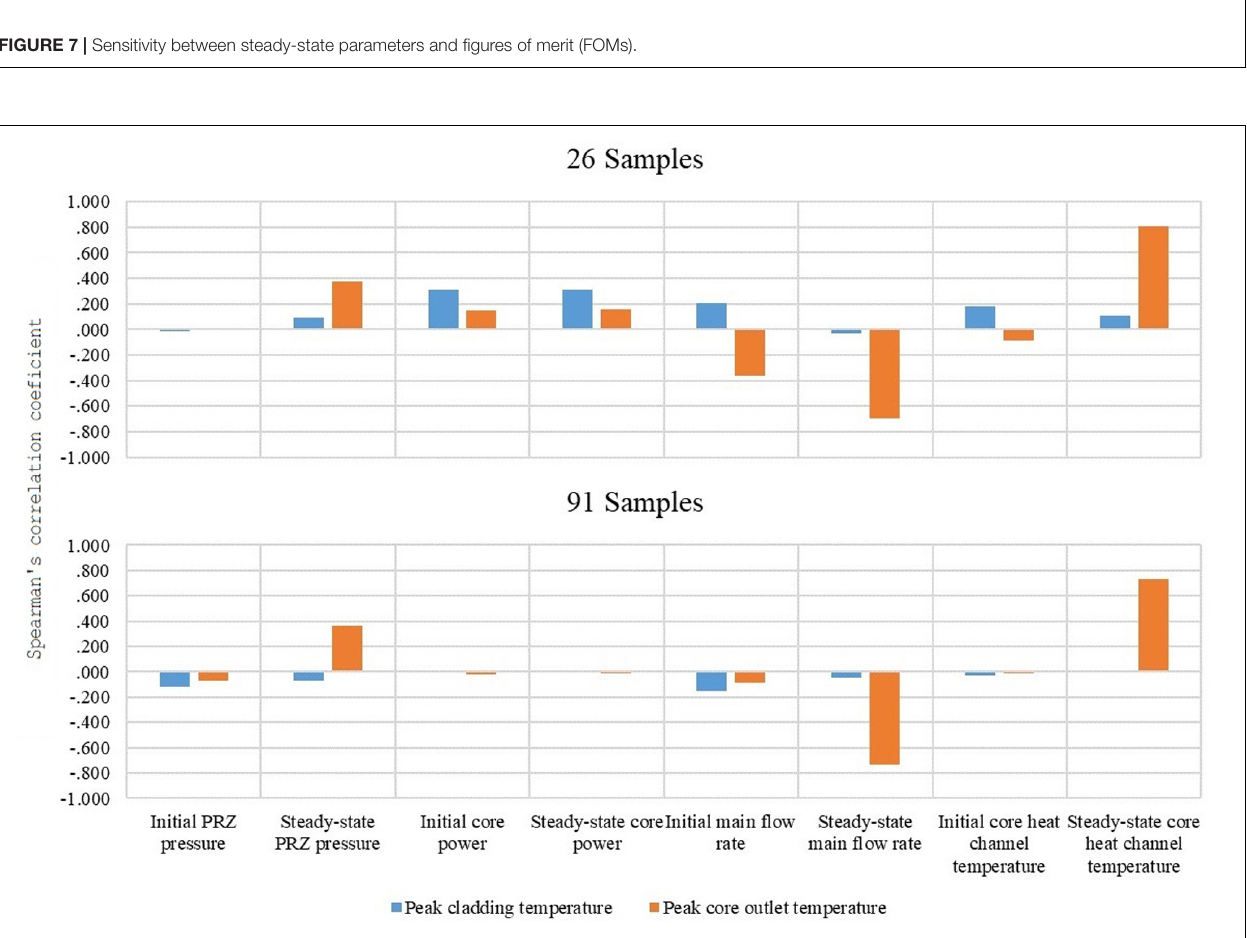
Frontiers in Energy Research |